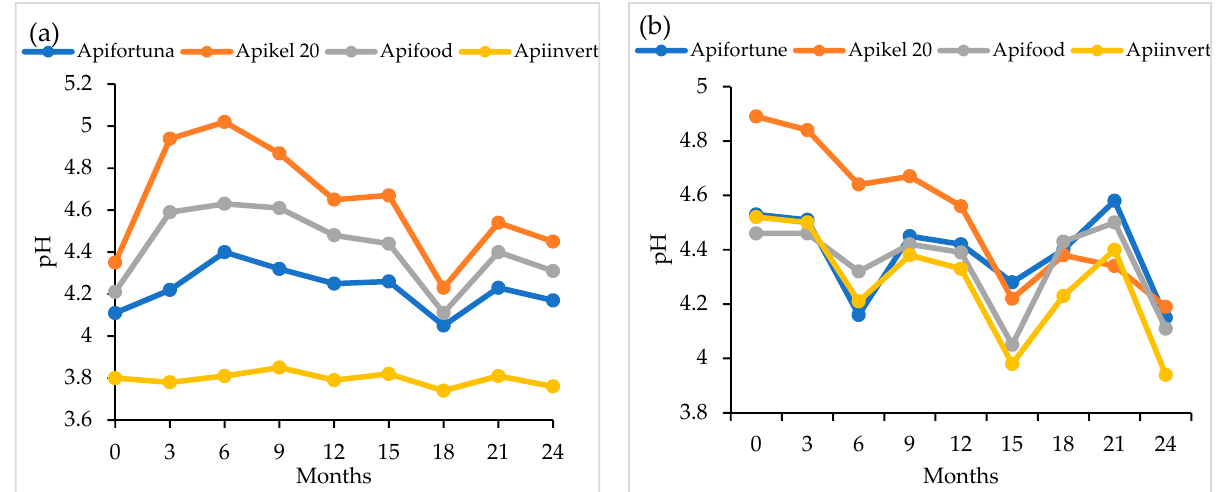
Figure 19. Changes of pH of syrups during storage at ca. 4 °C ( a ) from 2012 and ( b ) from 2013. Free acidity of fresh starch syrups purchased in 2012 and 2013, respectively, was 4.8 mval/kg and 1.2 mval/kg on average (Table 1). Free acidity of the inverted saccharose syrup (Apiinvert) amounted to 5.9 mval/kg and 0.9 mval/kg, respectively. In starch syrups and the inverted saccharose syrup purchased in 2012 stored at three different tempera- tures (ca. 20 °C, 10–14 °C, and ca. 4 °C), a slight decrease was observed. In the syrups purchased in 2013, a slight increase in the free acidity was found. However, free acidity of stored syrups oscillated around the values determined in fresh syrups. Electrical conductivity of fresh starch syrups and the inverted saccharose syrup was very low (0.01–0.05 mS/cm) (Table 1) and did not change during storage. After 24 months, the value of this parameter was at the similar level as fresh syrups and, in all cases, did not exceed 0.05 mS/cm. In addition, no changes in water content during storage in the experimental conditions were found in all the tested starch syrups and the inverted sac- charose syrup. Water content amounted to 20–23% in starch syrups and 26–27% in the inverted saccharose syrup (Table 1). 4. Discussion There are no reliable literature data on changes in the physicochemical parameters of analyzed syrups during storage under different conditions. So far, conducted studies on the changes in chemical composition during storage in different conditions (temperature, time) have mainly concerned honey, which is a natural carbohydrate food for bees. There- fore, the products intended for the winter feeding of bees (being an alternative to honey) should have comparable sugar composition and other physicochemical properties such as pH and acidity. These products should also have a low content of HMF, which can be a potential threat to honeybees. It can be assumed that biochemical changes, especially concerning HMF content in starch syrups during storage, are similar to honey. Our stud- ies showed that the changes in chemical composition of starch syrups and the inverted saccharose syrup during storage in different conditions mainly involved the HMF content. This compound forms in products with high content of simple sugars (fructose and glu- cose) such as honey during heating at the stage of decrystallization and during storage. The rate of HMF formation is mainly a function of temperature and time [18,19,31,32]. The abovementioned authors have indicated that, on the one hand, analyzing HMF in food products is used to monitor changes occurring during heating, while on the other hand, HMF is treated as a compound unwanted in foods due to its toxic, mutagenic, and can- cerogenic properties.